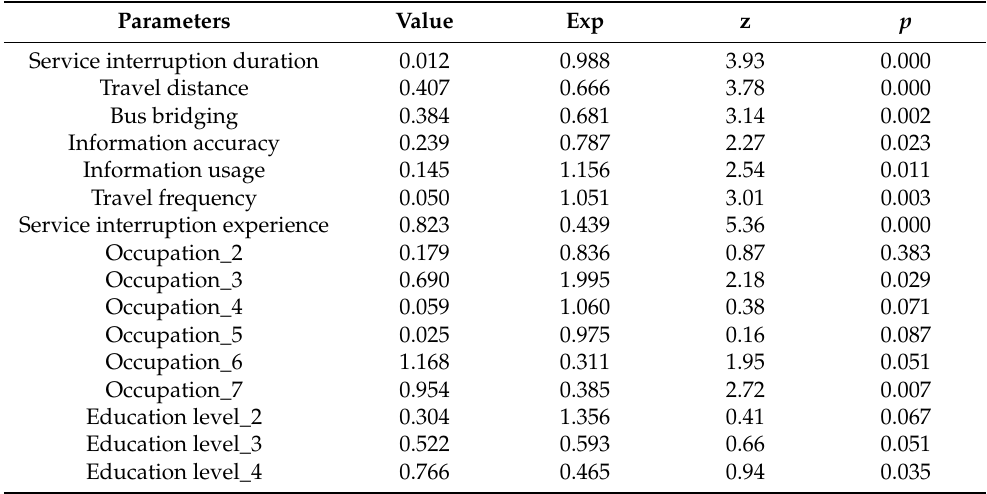
Table 10. AFT result of the passenger waiting tolerance during URT service interruptions.